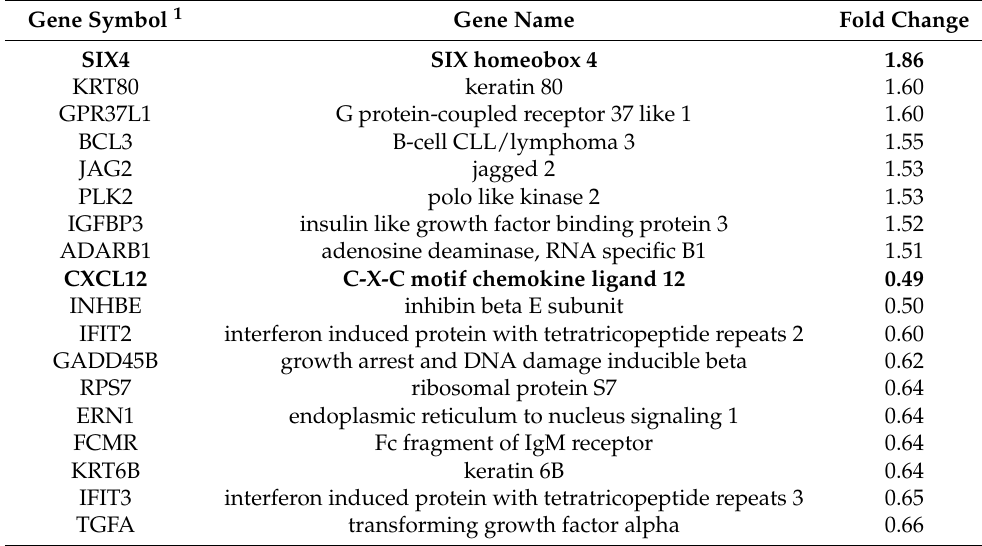
Table 5. List of cell-death-related genes differentially expressed only in MCF7-ER β 2 cells. Gene Symbol